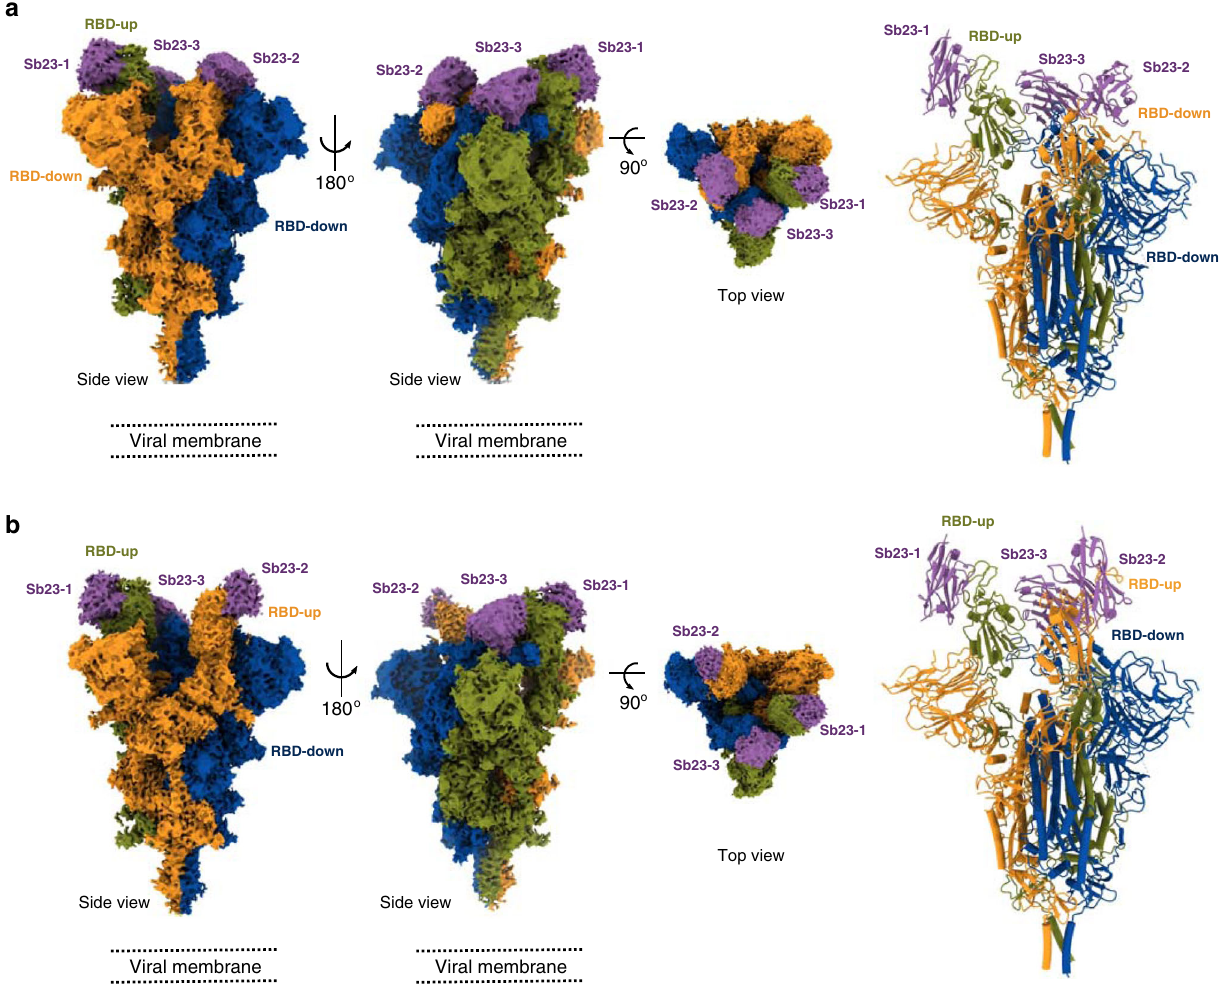
Fig. 5 Cryo-EM reconstruction of SARS-CoV-2 spike bound to Sb23. a Locally sharpened Coulomb potential map and cartoon model of Sb23 bound to the spike protein in the “ 1-up ” conformation and cartoon model of Sb23-bound spike. b Locally sharpened Coulomb potential map and cartoon model of Sb23 bound to the spike protein in the “ 2-up ”